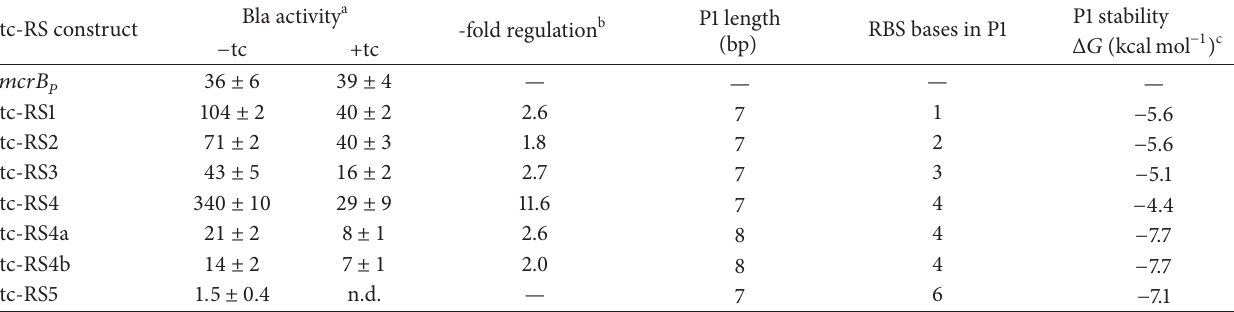
Table 2: tc-dependent Bla activity in M. acetivorans strains carrying mcrB 𝑃 - tc - RS - blaN gene